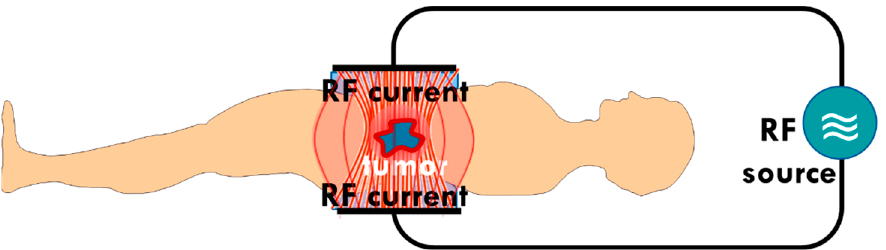
Figure 3. Schematic representation of the patient forming part of the tuned electric circuit. The low impedance of the tumor drives the current to select the malignant cells. There is precise, real-time control of the impedance matching of the patient and the tumor in situ.